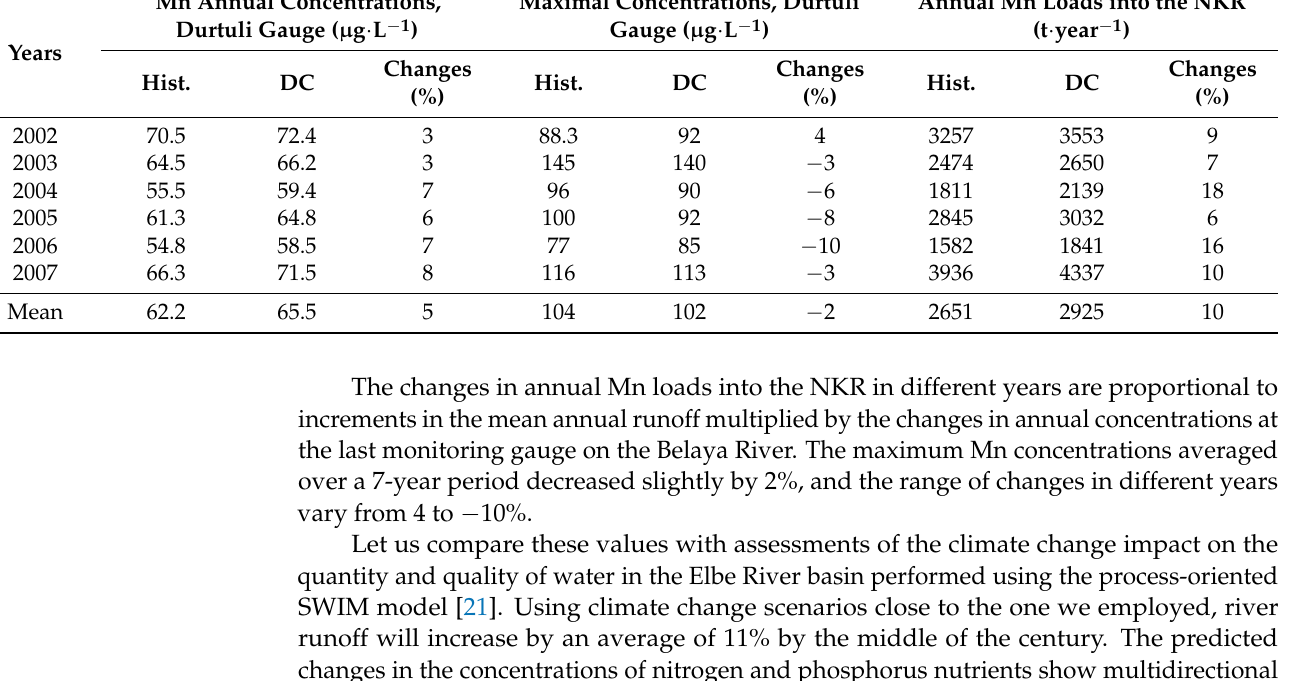
Table 5. Simulated water quality characteristics under historical data series and DC scenario for the 2002–2007 period.